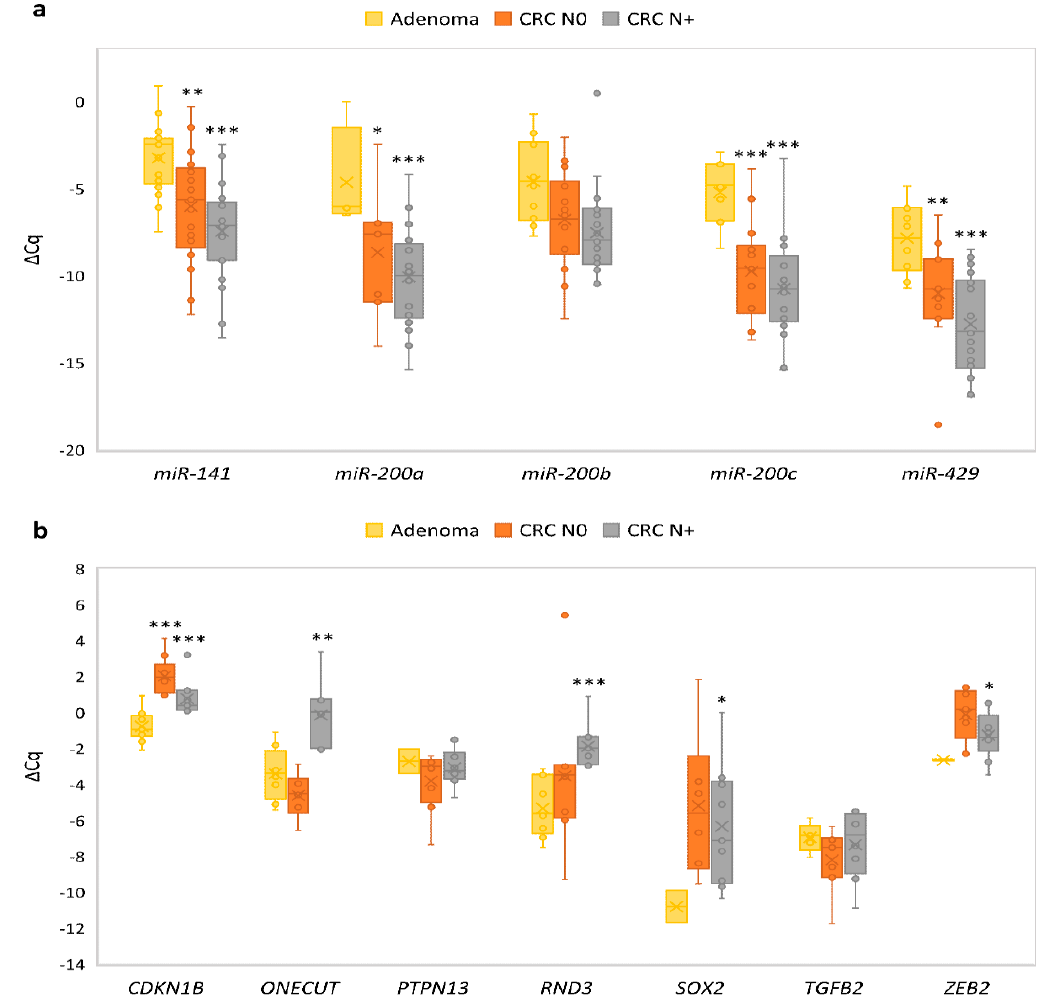
Figure 5. Expression of the miR-200 family and their target genes in adenoma ( n = 10) in comparison with CRC N0 ( n = 13) and CRC N+ ( n = 17): ( a ) expression of the miR-200 family; ( b ) expression of miR-200 family target genes. Legend: CRC, colorectal carcinoma; ∆ Cq, delta quantitation cycle; N0, without nodal metastases; N+, with nodal metastases; * p ≤ 0.05; ** p ≤ 0.01; *** p ≤ 0.001.